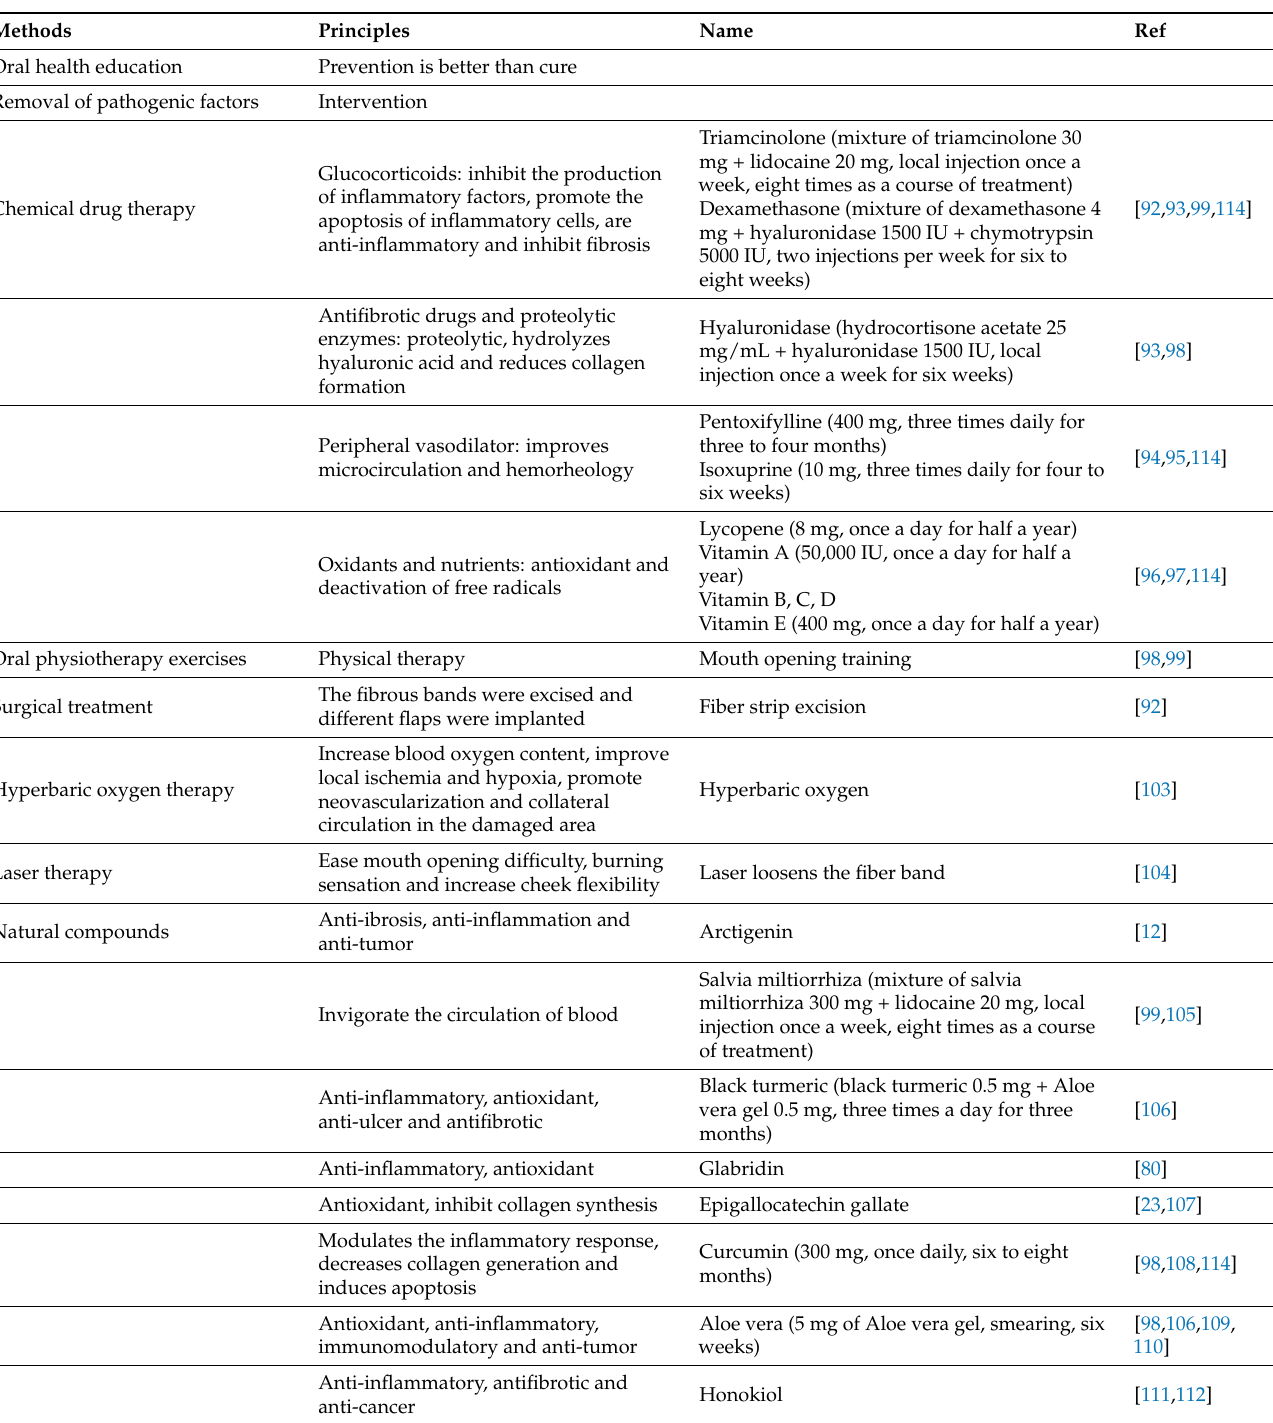
Table 1. Treatment methods and principles of